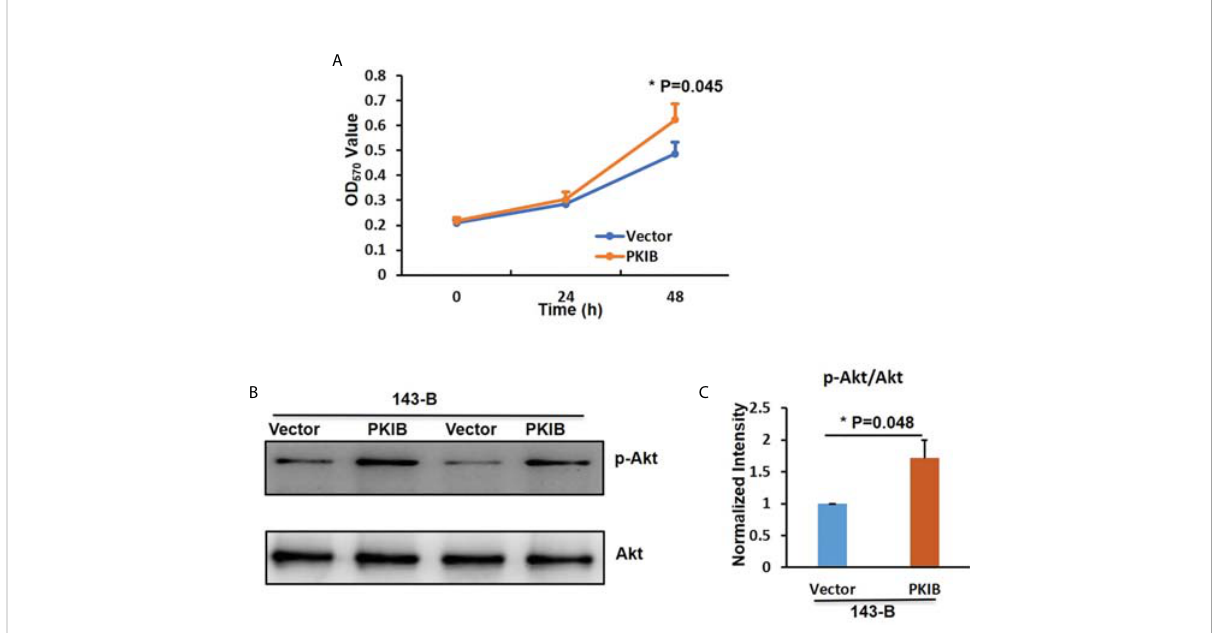
FIGURE 6 PKIB promotes the proliferation of osteosarcoma. (A) The OD450nm value to show the proliferation ability of 143B cells with or without PKIB overexpression as indicated. (B) Representative images of western blot to show the protein expression level of p-Akt and Akt. (C) Bar graphs showed the normalized intensity of p-Akt as indicated in panel B. n>=3, Error bars: Mean±SD,